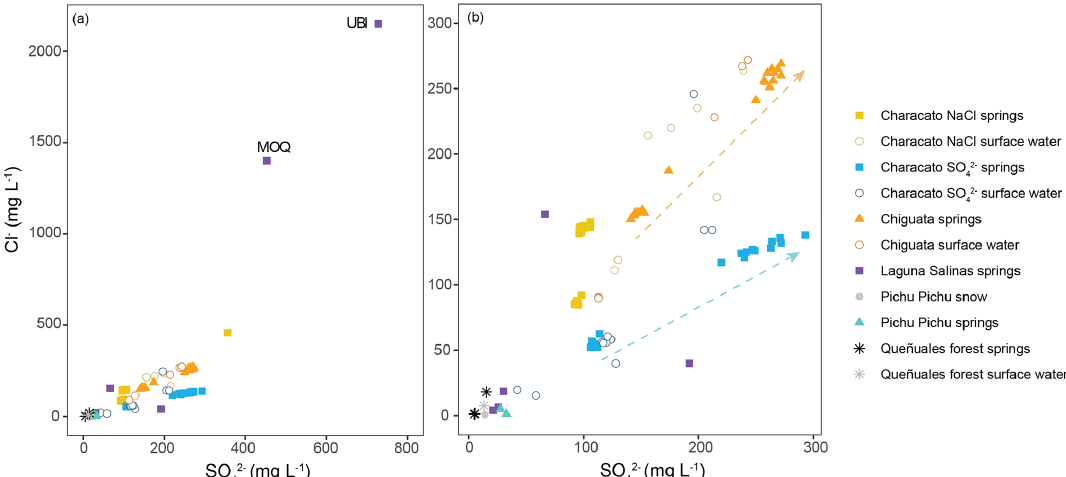
Figure 8. Relationships between Cl − and SO 42 − of (a) all water samples, except Laguna Salinas surface water, and (b) excluding two Laguna Salinas springs (UBI and MOQ) with high Cl − . Dashed lines indicate patterns of chemical evolution or mixing and not statistical trend lines. The orange evolution line connects springs along the Río Andamayo fault system, and the blue line connects springs in the Characato District furthest from the Río Andamayo in a separate cluster of shorter